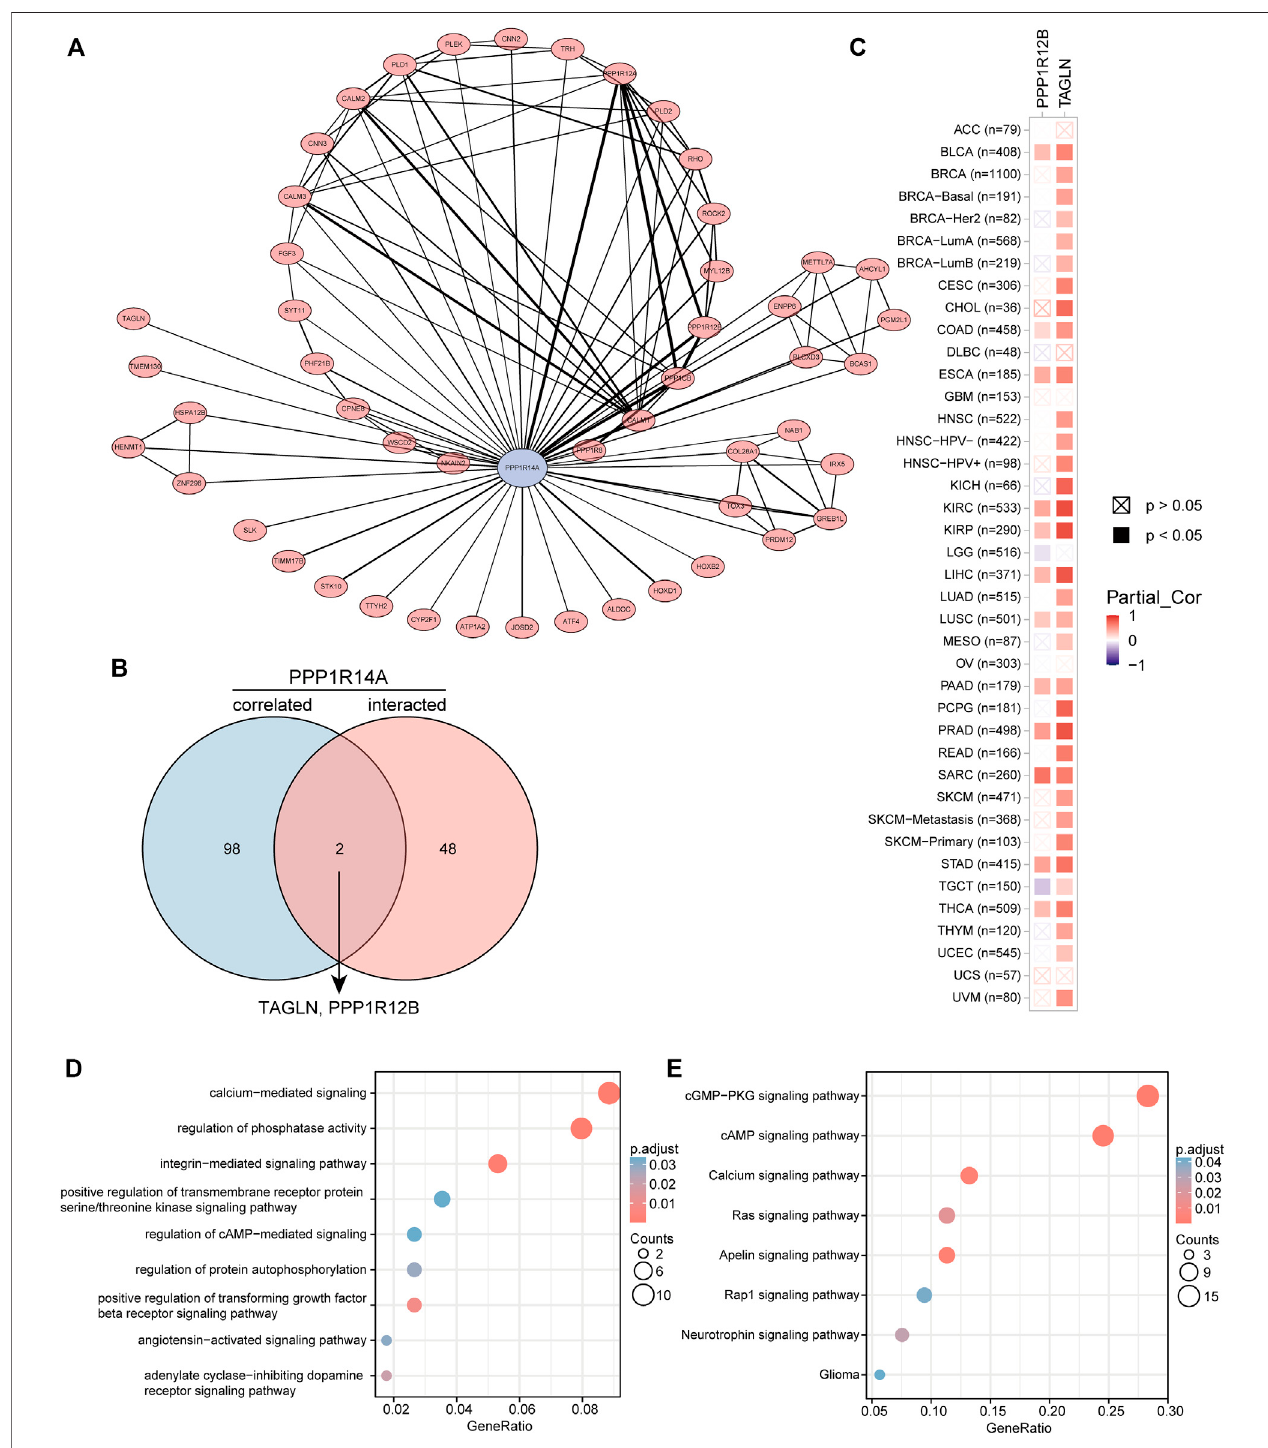
FIGURE 14 | PPP1R14A-related gene enrichment analysis. A PPI network displays the available experimentally determined PPP1R14A-binding proteins. PPP1R14A is marked by blue color, line thickness represents combined score (A) . Using the GEPIA2 approach, we also obtained the top 100 PPP1R14A-correlated genes and constructed a Venn diagram with molecules that have a physical binding relationship with PPP1R14A, and it is found that there are two molecules, including TAGLN and PPP1R12B in the overlapping area (B) . Corresponding heatmap exhibits the relationship between PPP1R14A and the two intersecting molecules in the detailed cancer types (C) . Based on the PPP1R14A-binding and related genes, GO (D) and KEGG (E) pathway analysis was performed and displayed through bubble charts.